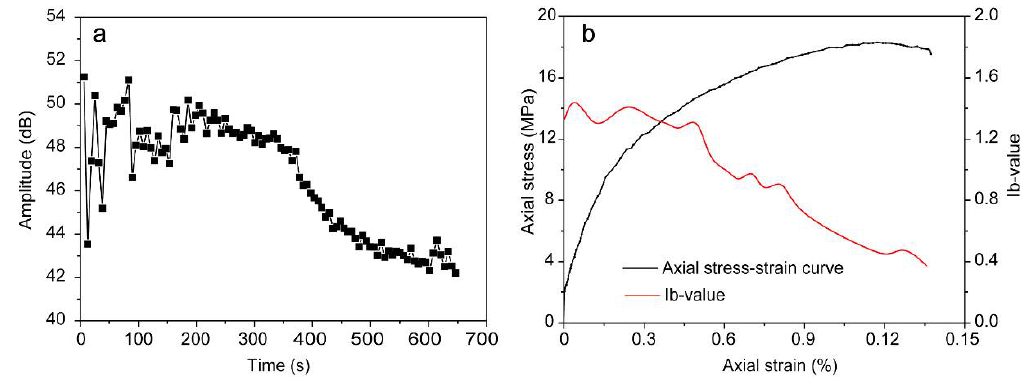
Figure 9. ( a ) Variation of AE hit average amplitude with loading time for sample SA-2 under uniaxial compression; ( b ) relationship between axial stress-strain curve and Ib -value during different deformation stages for sample SA-2 under uniaxial compression.